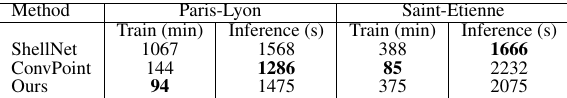
Table 3. Comparison of compute time for training phase and inference phase on both datasets (lower is better)